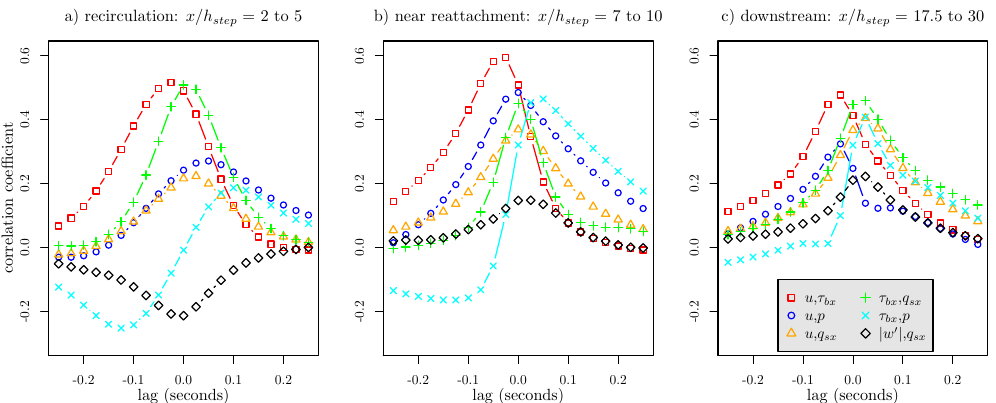
Figure 3. Correlation coefficients vs. time lag for various pairs of flow and transport variables as indicated in the legend in (c) . The lag is of the second variable relative to the first variable in the legend shown in (c)